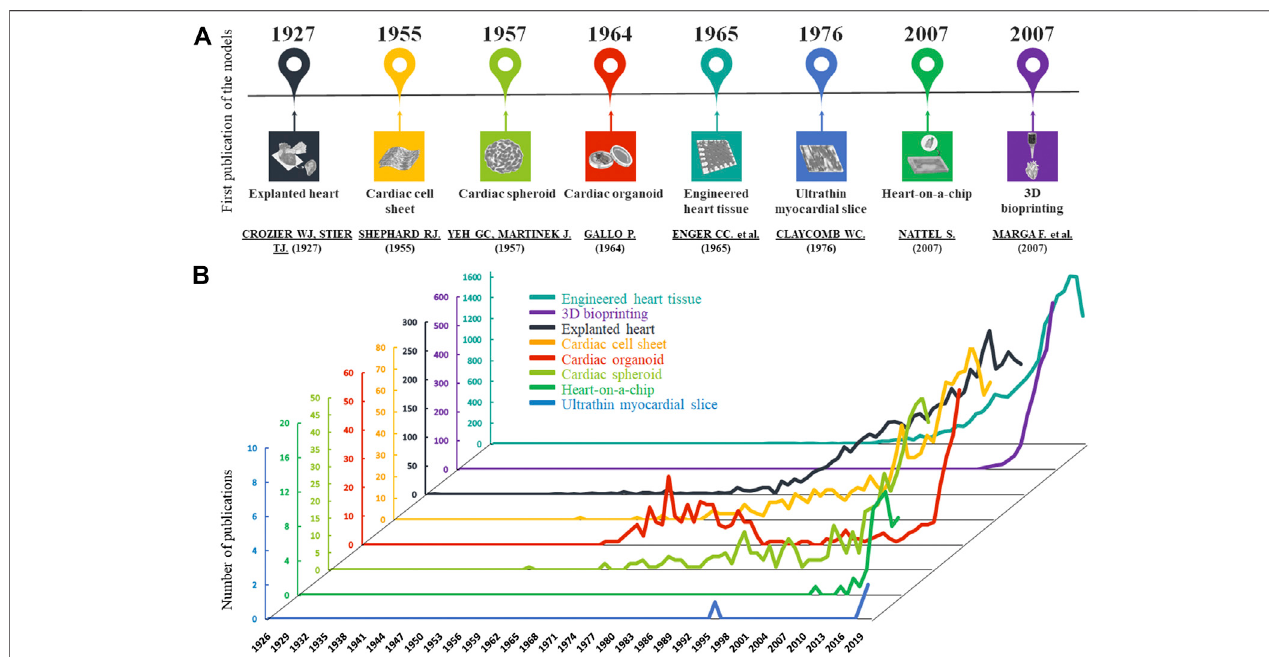
FIGURE1| Developmentofcardiacmodels. (A) :ThegraphsshowthenumberofpublishedarticlesofthedifferentmodelsonatimelinebasedonPubMeddata.In the last 20 years, the number of publications has increased in all cases. (B) : The timescale presents the fi rst publications of the cardiac models based on PubMed.